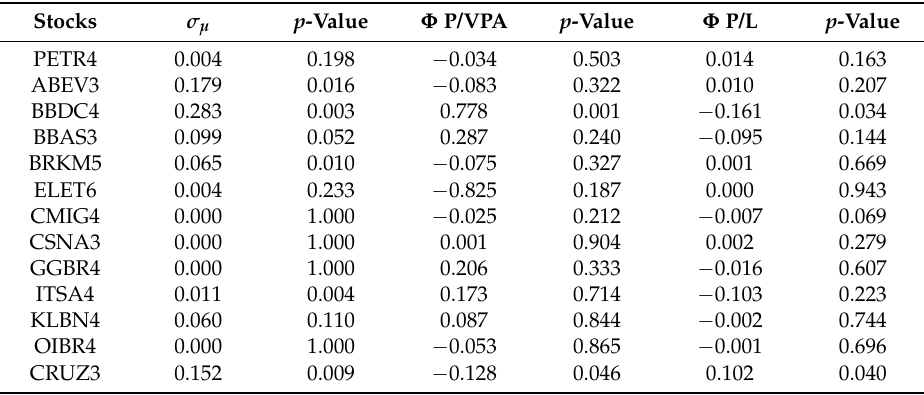
Table A3. Coefficients of the model with price